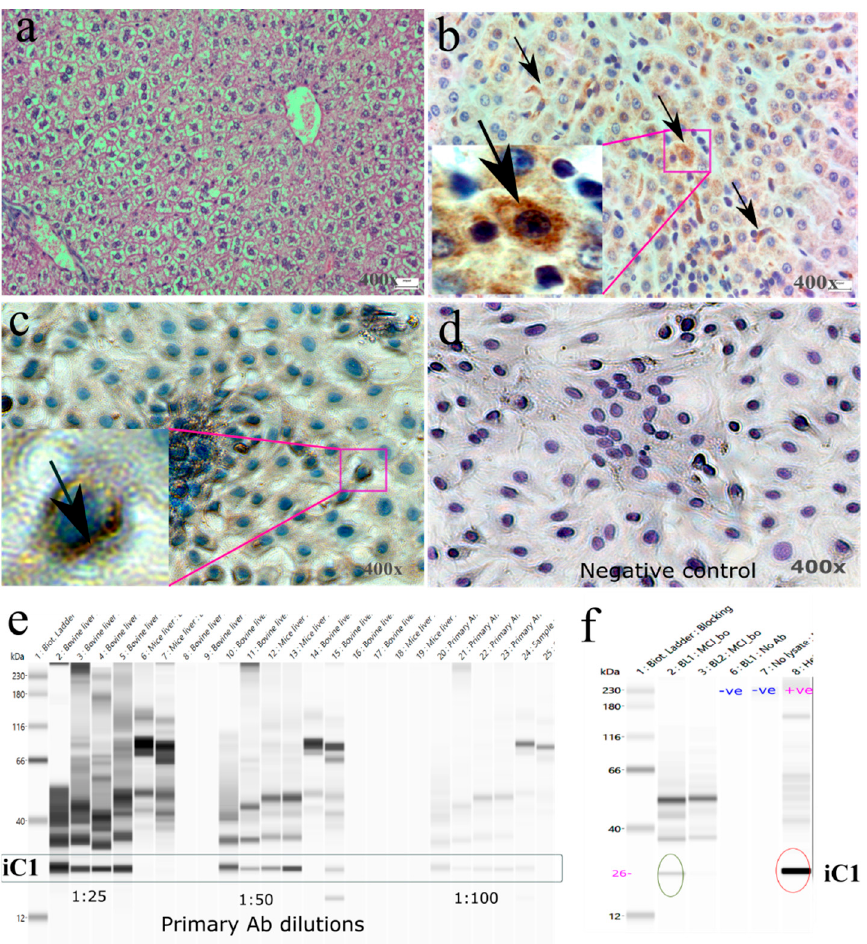
Figure 3. Protein expression of iC1 in bovine livers. Hematoxylin and eosin staining of bovine livers showing the morphology of healthy bovine livers obtained from slaughter ( a ). Immunolocalization of iC1 was observed in the cytoplasm of hepatic cells (arrows and magnified images of cellular localization of iC1 are shown) in liver tissue ( b ) and primary hepatic culture ( c ). Negative runs of iC1 immunostaining performed by the omission of primary antibody showed no positive brown staining ( d ). Standardization of anti-rabbit primary antibody dilution of iC1 in capillary Western blot (ProteinSimple of the Wes model) showed a specific gel-like band of iC1 protein in bovine liver tissue lysates, showing a decreased intensity of the protein band as the antibody was diluted further ( e ). After standardization of primary antibody dilution, the iC1 band is shown in tissue lysate ( f ). The omission of primary antibody and no-cell lysate were the two negative controls. The lysate of HeLa cell was used as a positive control of Wes runs. Protein band of iC1 in bovine liver and HeLa cells are encircled.